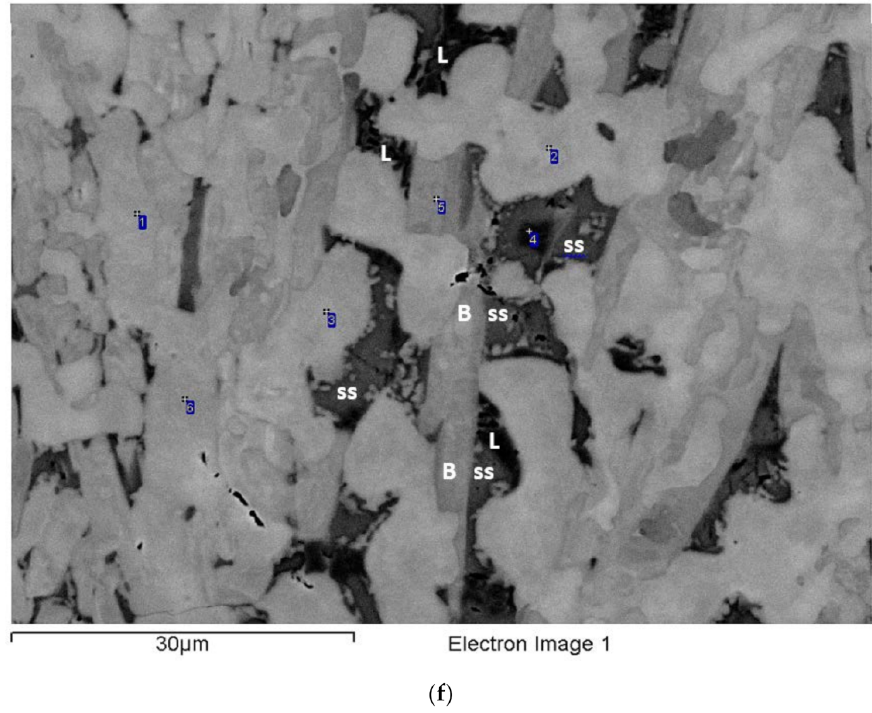
Figure 10. BSE images of the top ( a , b ), bulk ( c , d ), and bottom ( e , f ) of the ingot of EZ8-AC showing details of the microstructure. The Laves phase is indicated with L, and the Nb ss with ss. The A15- Nb 3 X is shown as Nb 3 Sn. In ( a ), the Nb 3 Sn is shown with the numbers 1, 6, and 7; the Ti- and Hf-rich Nb 5 Si 3 with the numbers 3, 4, 5, 8, and 9; and the Laves phase with 2. In ( b ), the Nb 3 Sn is shown with the number 1, and the Ti- and Hf-rich Nb 5 Si 3 with 3. In ( c ), the Nb 3 Sn is shown with the number 1, and the Ti- and Hf-rich Nb 5 Si 3 with 3. In ( d ), the Nb ss is shown with the number 4; Nb 3 Sn with 3, 5, and 6; Nb 5 Si 3 with 1; Ti- and Hf-rich Nb 5 Si 3 with 7 and 8; the Laves phase with 2; and HfO 2 is the very bright phase on the left-hand side of the number 5. In ( e ), Nb 3 Sn is shown with the numbers 1, 3, 4, and 5; the Nb ss with 6; and the Nb 5 Si 3 with 2. In ( f ), the Nb 3 Sn is shown with the numbers 1, 2, 3, and 6; the Laves phase with 4; and the Ti- and Hf-rich Nb 5 Si 3 with 5. For the areas A in ( b – d ) and the area B in ( f ), see